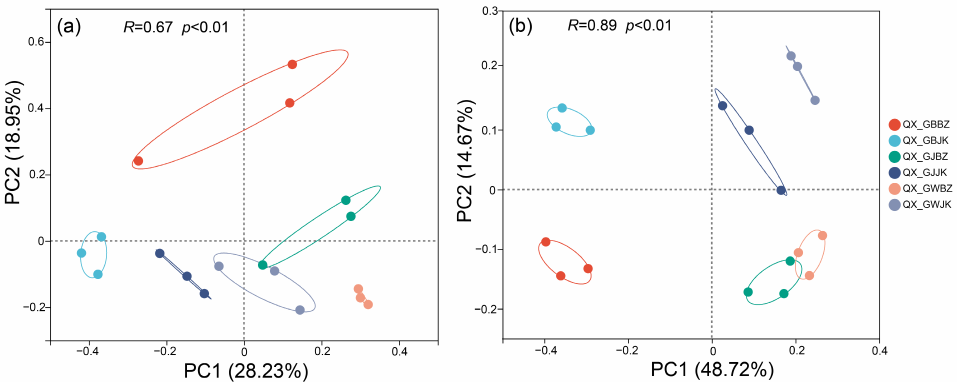
Figure 4. PCoA analysis at OTU level. Note: The PC coordinate axis in the principal coordinate analysis (PCoA) graph denotes the explanatory value of the difference in sample composition. ( a )